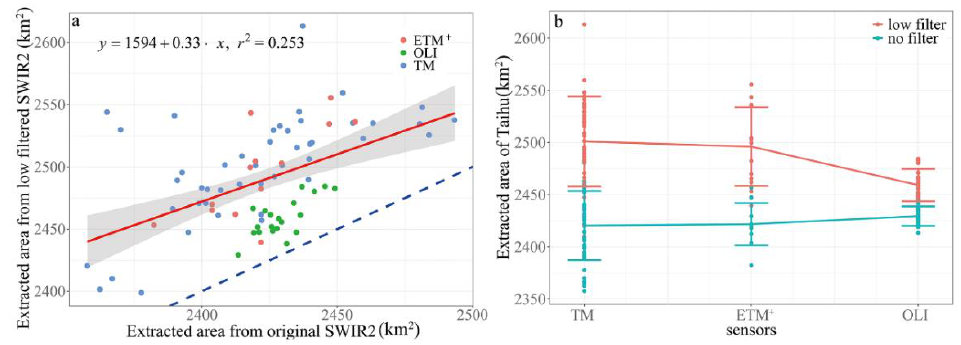
Figure 6. Comparison of extracted area by low and non-filtered imagery among three sensors. ( a ): comparison between the area of water extraction from low-filtered SWIR2 (second shortwave-infraredband)andoriginalSWIR2.( b ): errorbargraphforextractedwaterareaoflow-filtered andoriginalSWIR2amongthreedi ff erentsensors(TM = ThematicMapper; ETM + = EnhancedThematic Mapper; OLI = Operational Land